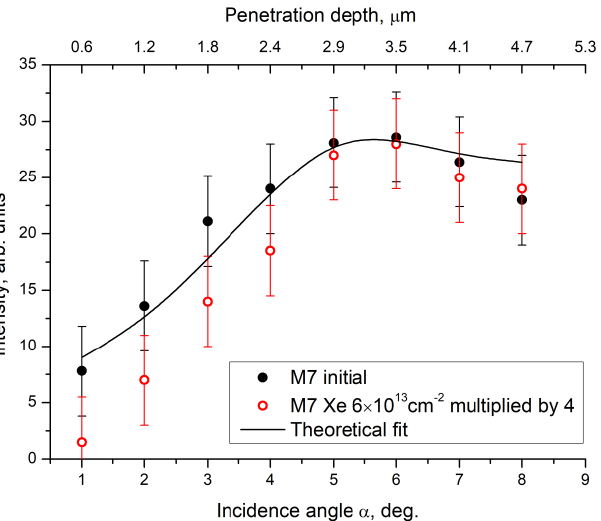
Figure 3. Dependence of integral intensity of a XRD peak (113) in Na 0.5 Zr 2 (PO 4 ) 2.5 (MoO 4 ) 0.5 phase on α incidence angle for Na 0.5 Zr 2 (PO 4 ) 2.5 (MoO 4 ) 0.5 ceramics before and after irradiation. Irradiation intensity is multiplied by a factor of 4. The calculated curve is plotted with due regard for material constants and the geometry of the experiment as if crystalline quality and phase composition of the material were uniform over the entire depth of analysis.